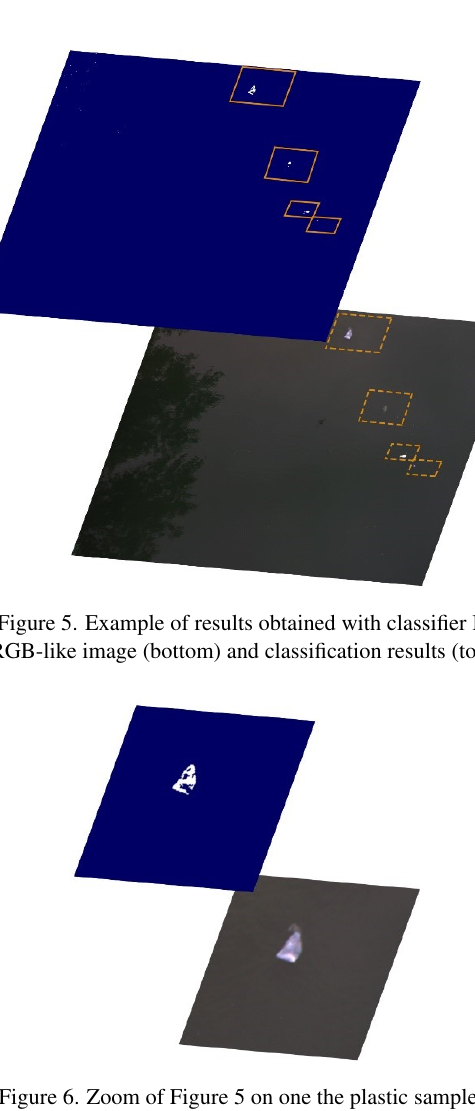
Figure 6. Zoom of Figure 5 on one the plastic samples.